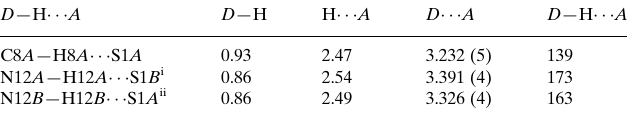
Hydrogen-bond geometry (A˚ , (cid:2)